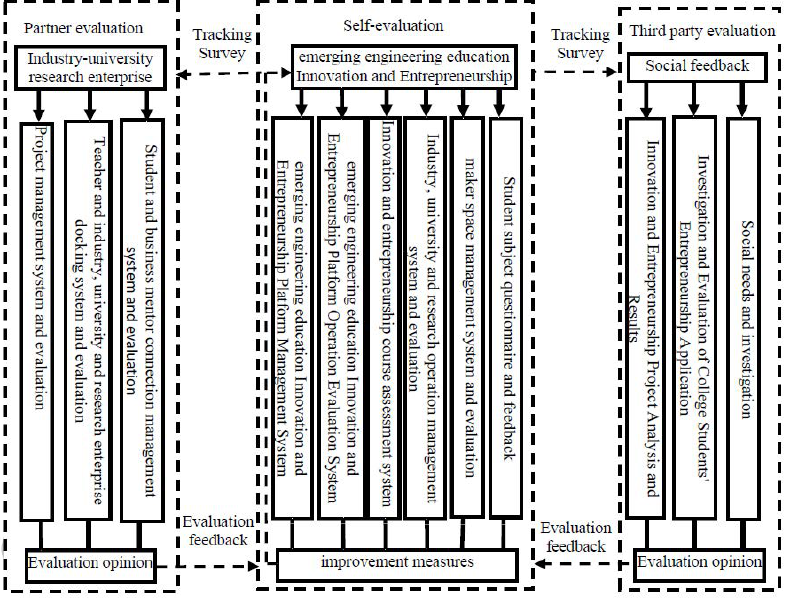
Fig. 2 Emerging engineering education innovation and entrepreneurship practice platform evaluation and improvement system.